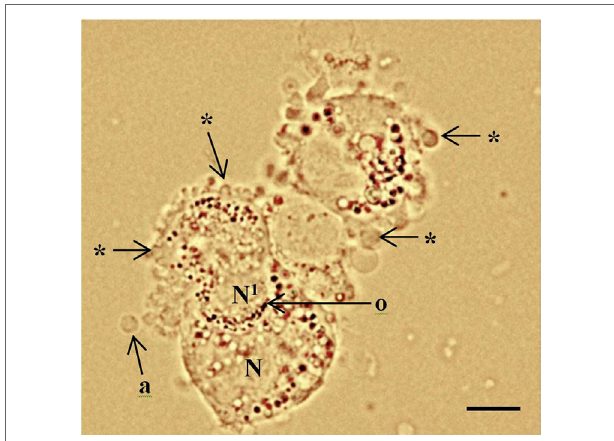
FiGURe 1 | Periluteal granulosa cells and cell morphology. Human granulosa cells were collected from a 15 mm follicle during an in vitro fertilization cycle at the time of oocyte collection. The granulosa cells are peri-luteal cells; however, the cytoplasm is still relatively compact compared to granulosa cells collected from ovulatory follicles (5). The granulosa cells have dense clustering of organelles around the large round nucleus (N). The cytoplasm appears granular during the late stages of follicular phase; large lipid droplets contain hormones. Cytoplasmic extrusions or blebbing, which indicates late apoptosis are shown (*); apoptotic bodies (a); organelles (o) clustered around the nucleus. Healthy granulosa cell (N) without blebbing is engulfing a neighboring apoptotic granulosa cell nucleus (N1) via phagocytosis (10). Bar 5